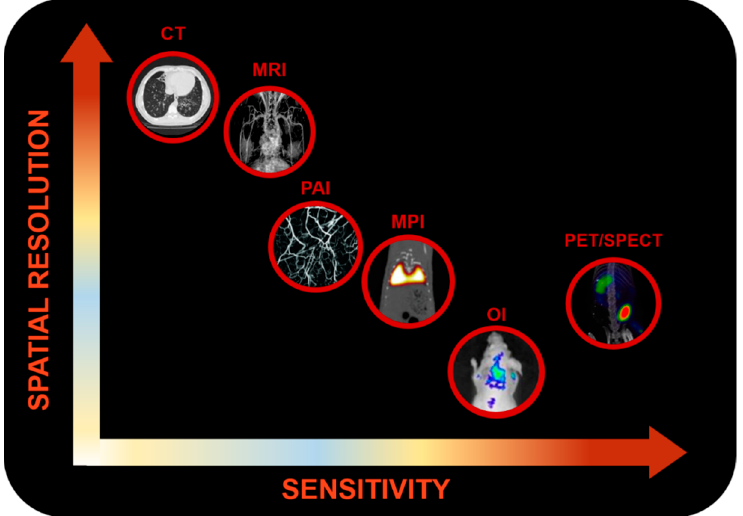
Figure 1. Graphical representation of different molecular imaging (MI) techniques classified by their sensitivity and spatial resolution. Computed tomography (CT) image adapted with permission from Reference [27]. Photoacoustic imaging (PAI) image adapted with permission from Reference [28]. Magnetic particle imaging (MPI) image adapted with permission from Reference [22]. Optical imaging (OI) image adapted with permission from Reference [29]. Positron-emission tomography (PET) image adapted with permission from Reference [30].